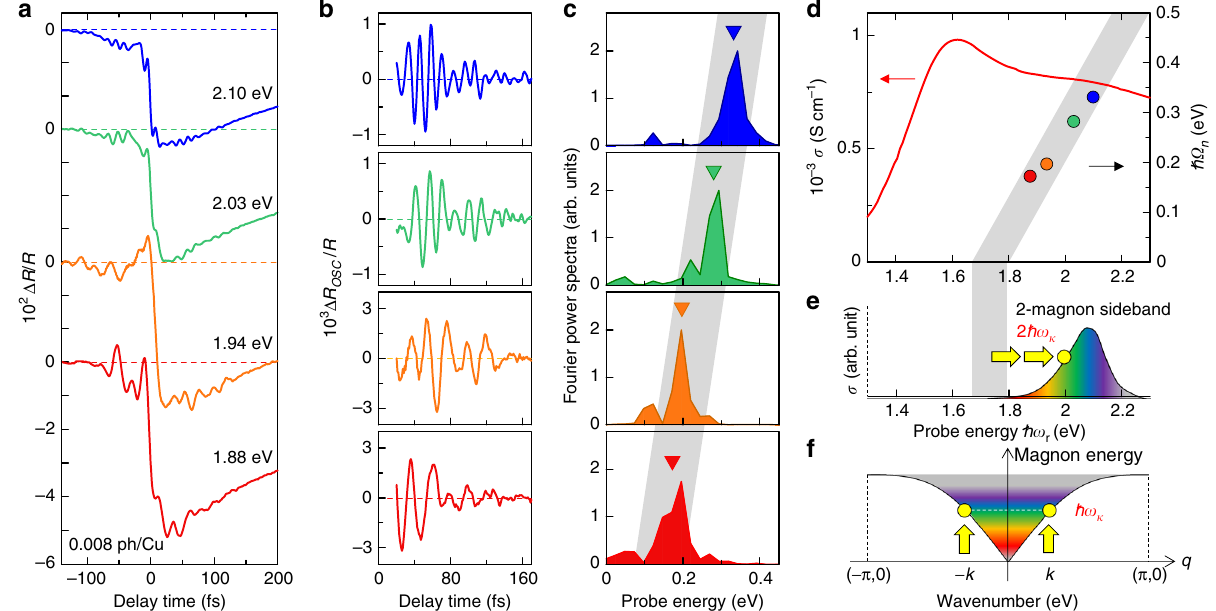
Fig. 4 Probe energy dependence of re fl ectivity changes in Nd 2 CuO 4 . a Time evolutions of Δ R / R for x ph = 0.008 ph/Cu. The red, orange, green, and blue colors show the data at the probe energies ( ħ ω r ) of 1.88, 1.94, 2.03, and 2.10 eV, respectively, in ( a – d ) in common. b Oscillatory components Δ R OSC / R extracted from Δ R/R . c Fourier power spectra of Δ R OSC / R . Triangles indicate the oscillation frequencies ħ Ω n . d Probe energy dependence of ħ Ω n . The solid line shows the σ spectrum. The broad gray line is drawn from 1.73 eV ( ħ ω CT ) with the slope of 1 (see the text). e A two-magnon sideband is schematically shown as the shaded area. f Schematics of the magnon